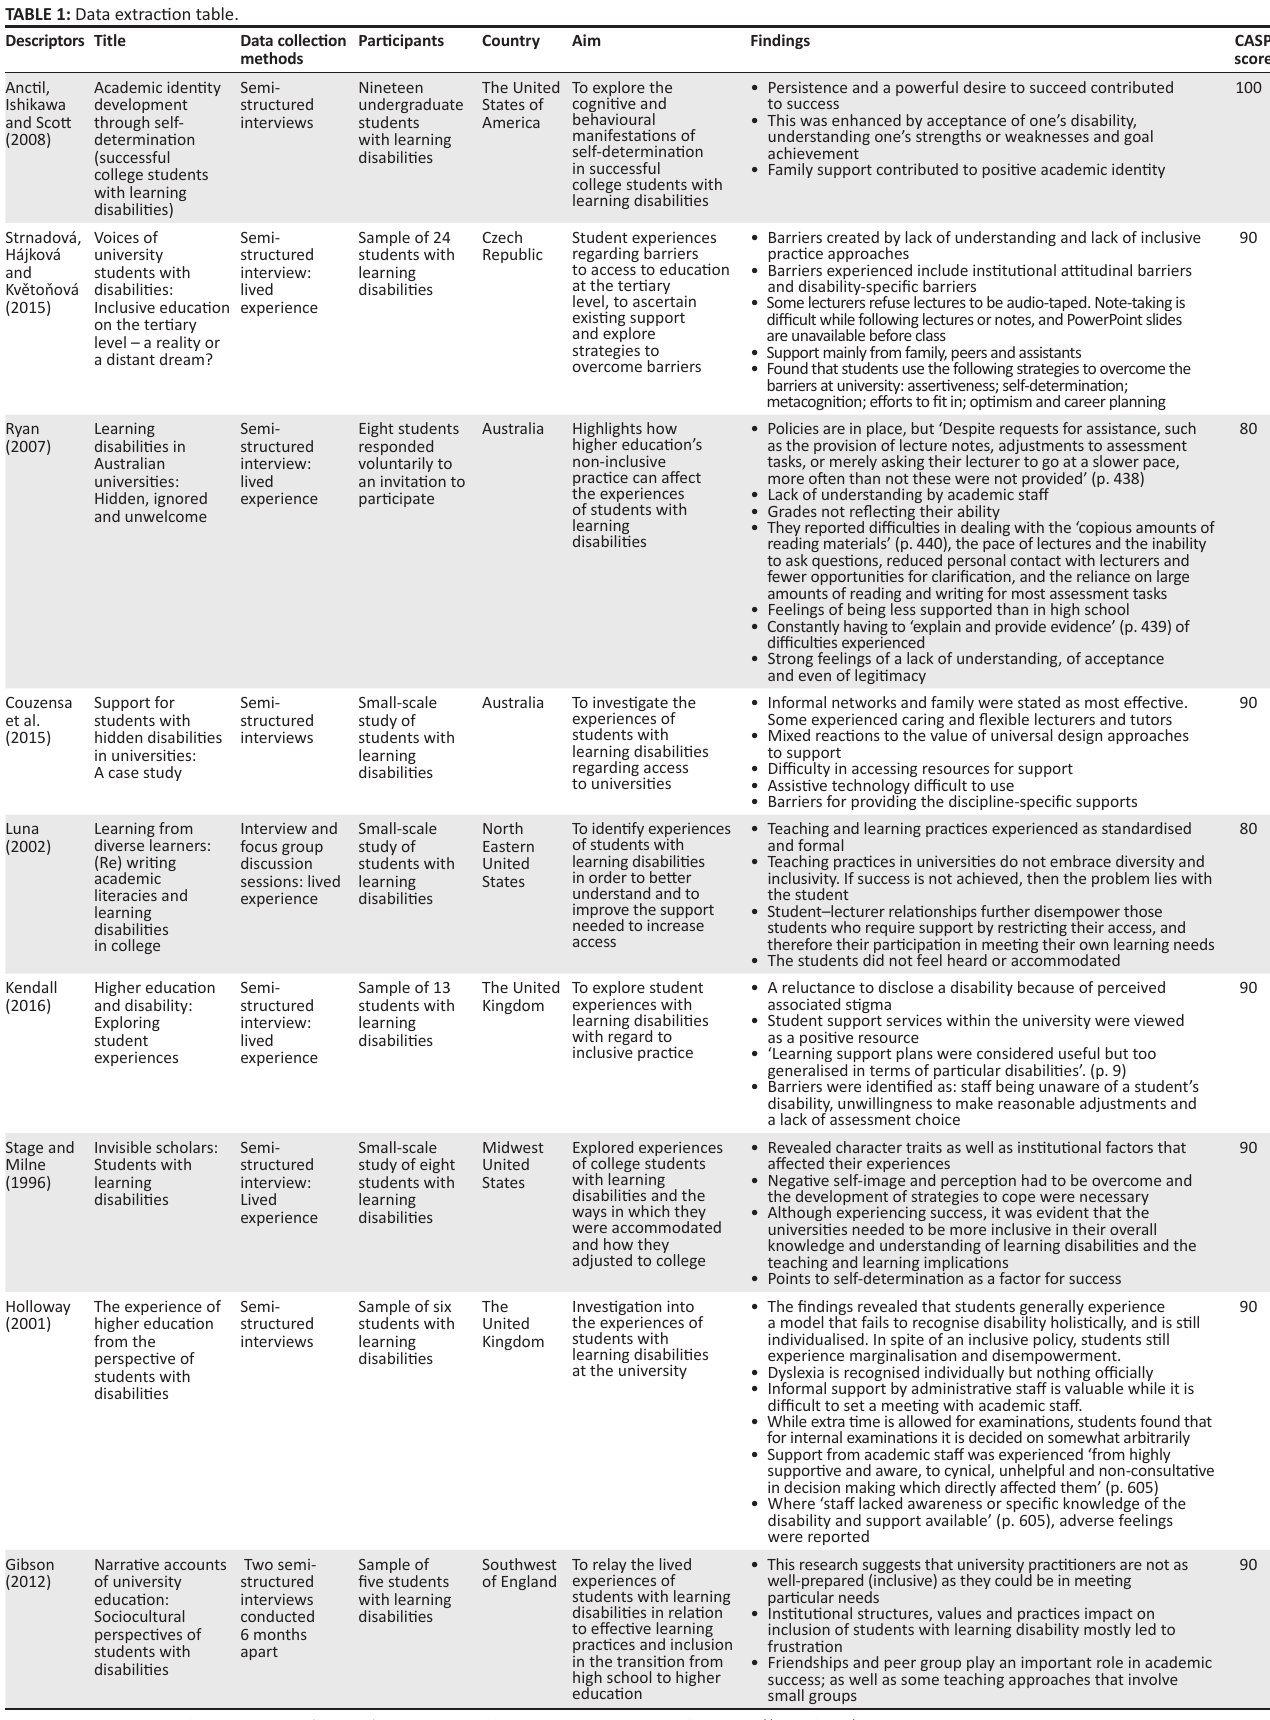
TABLE 1: Data extraction